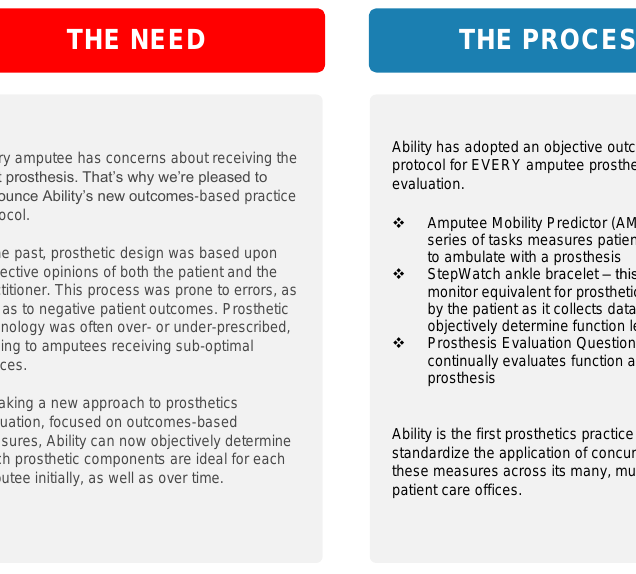
Figure1: Ability’s Lower Limb Prosthetics (LLP) outcome measure